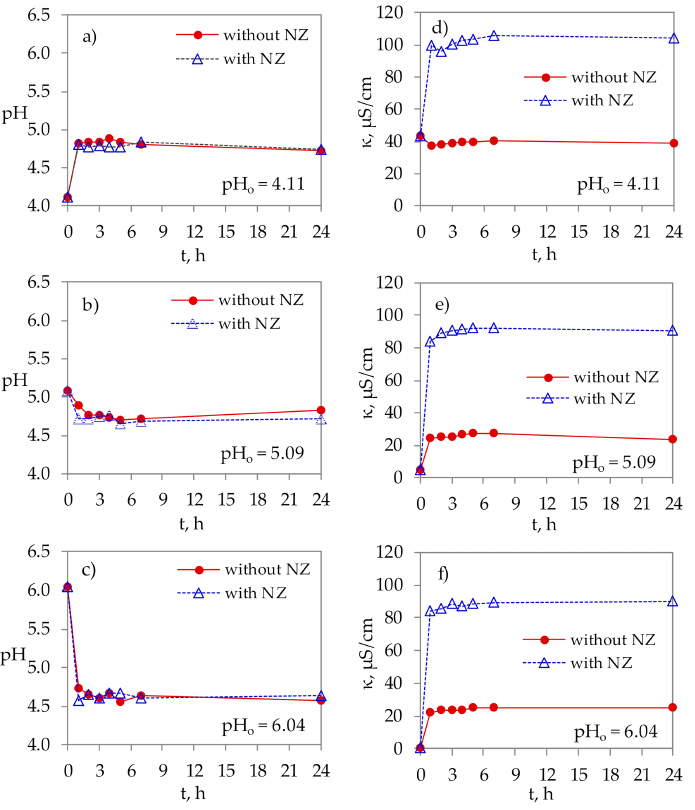
Figure 17. Change in: ( a – c ) pH and ( d – f ) electrical conductivity in suspensions during soil leaching without and with the addition of natural zeolite for three different pH o values of ultrapure